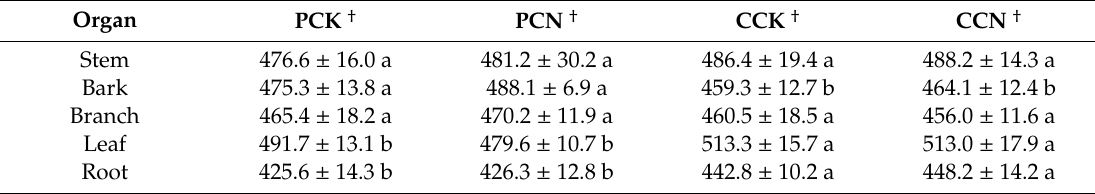
Table 3. Carbon (C) content of di ff erent organs of Pinus massoniana and Cunninghamia lanceolata (mean ± standard error, n = 4, g · kg − 1 ).